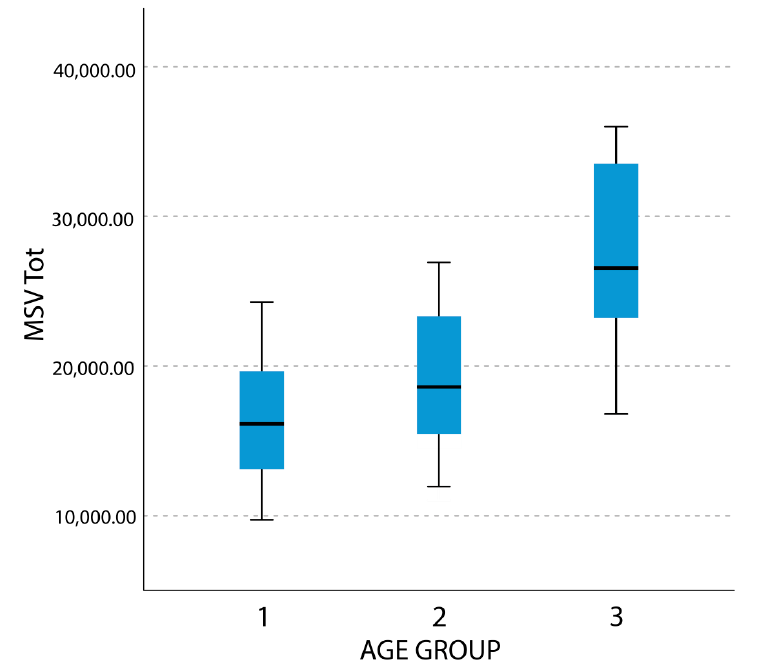
Figure 5. Boxplot representing total maxillary sinus volume (MSV Tot) in male subjects.